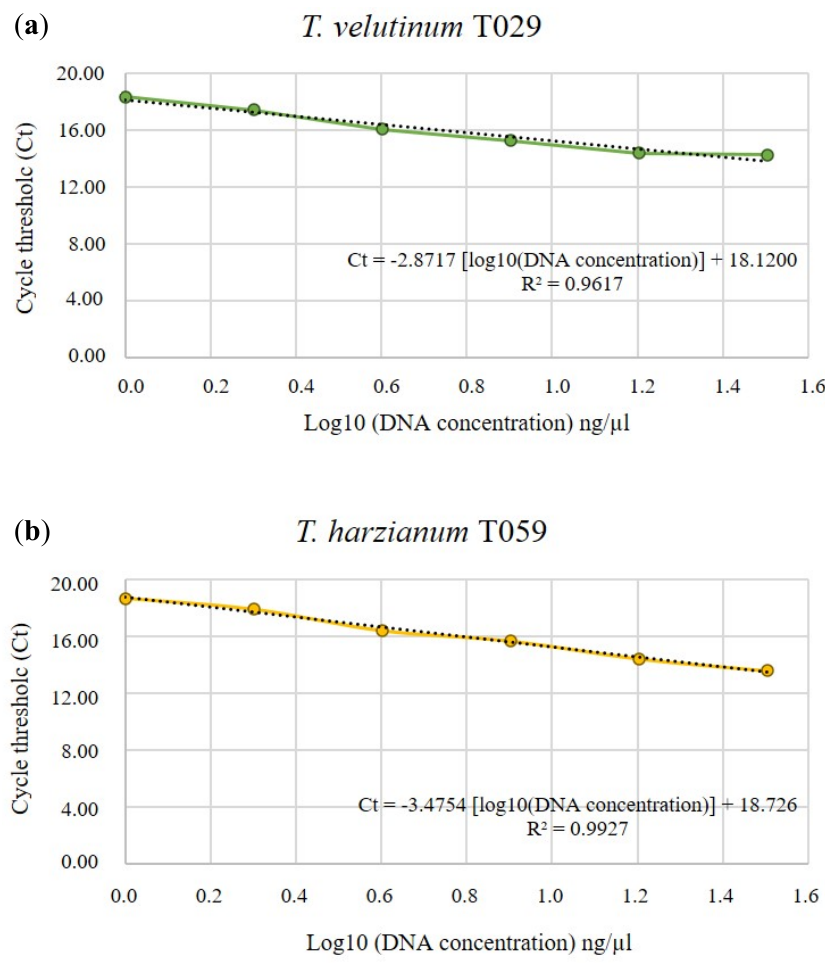
Figure 1. Standard curves of T. velutinum T029 ( a ) and T. harzianum T059 ( b ) DNA concentration standards vs. the cycle threshold (Ct) values from a qPCR. Ct values were plotted against logarithmically transformed DNA amounts ranging from 10 ng to 320 ng of genomic DNA· μ l − 1 . The linear regression equation is written in every graph with its linear regression coefficient (R 2 ).